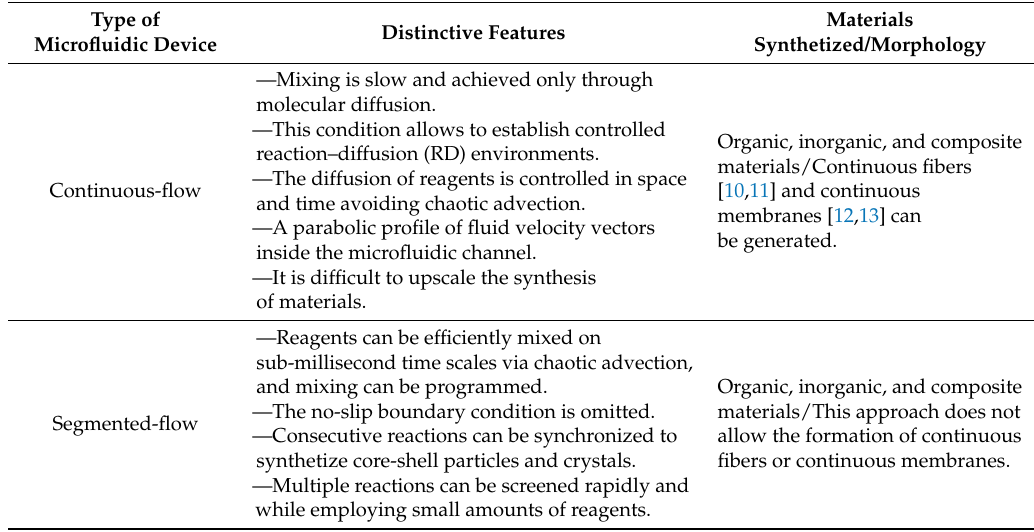
Table 1. Major differences/advantages for continuous- and segmented-flow microfluidic devices used for materials